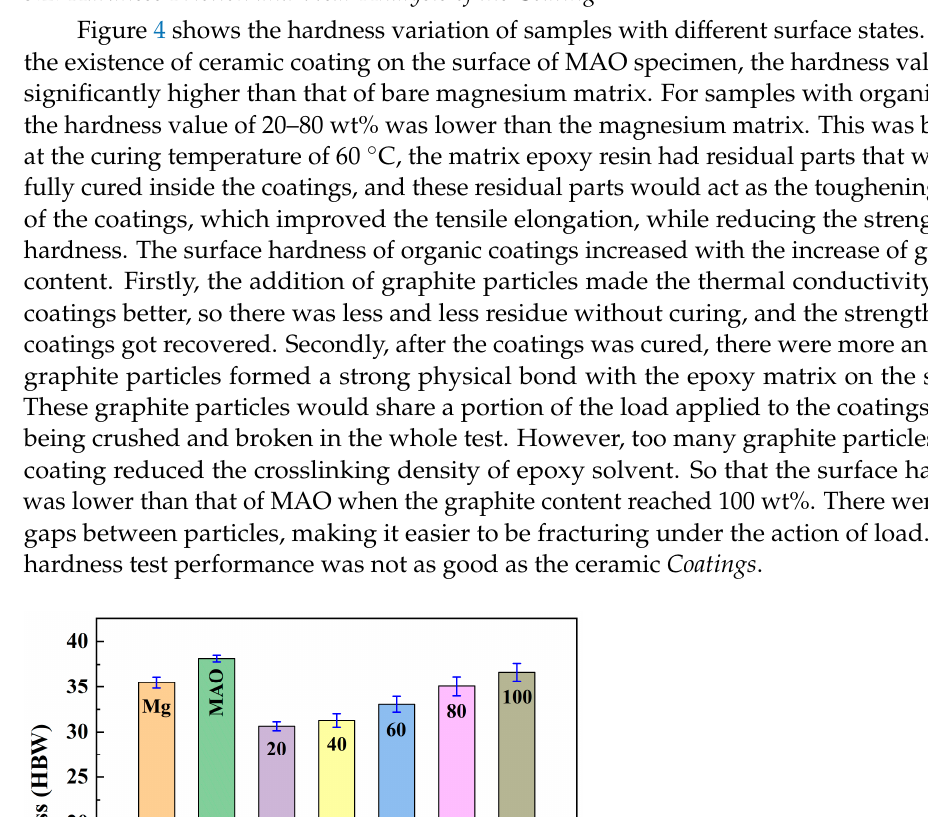
Figure 3. Cross-section morphologies of the graphite-epoxy coatings: ( a ) 20 wt%, ( b ) 40 wt%, ( c ) 60 wt%, ( d ) 80 wt%, ( e ) 100 wt%, and ( f ) coating interface of the Mg, micro-arc oxidation, and graph- ite/epoxy (3000×).